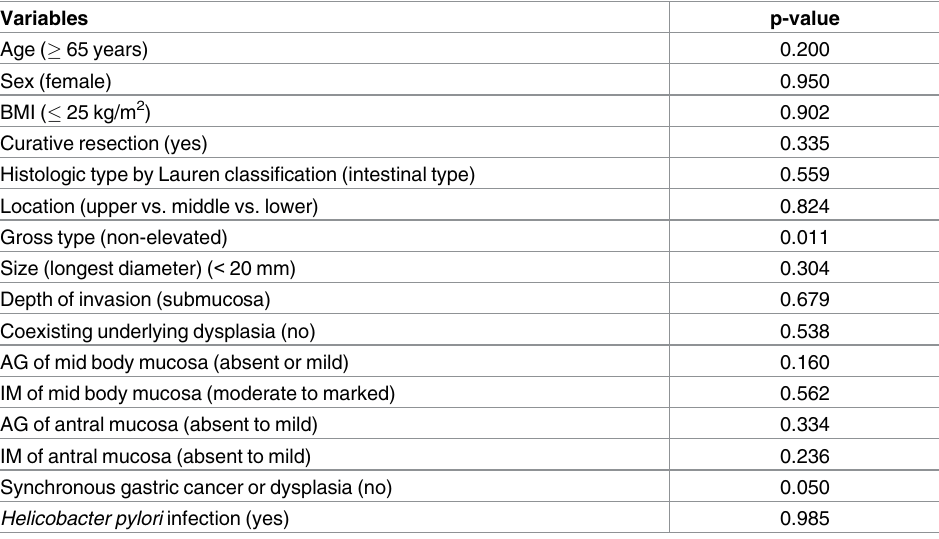
Table 2. Univariate analysis of risk factors for early occurrence of MGT after endoscopic resection of